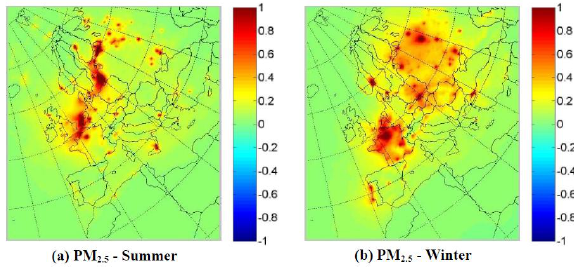
Fig. 8. Predicted reduction (base case – emissions reduction sce- Figure 8. Predicted reduction (base case - emissions reduction scenario) in ground-level 3 nario) in ground-level concentrations (µgm − 3 ) of total OA after concentrations (μg m -3 ) of total OA after a 50% reduction of anthropogenic POA emissions 4 a 50% reduction of anthropogenic POA emissions during (a) the during (a) the modeled summer period and (b) the modeled winter period. A positive value 5 modeled summer period and (b) the modeled winter period. A pos- corresponds to a decrease. 6 itive value corresponds to a decrease.